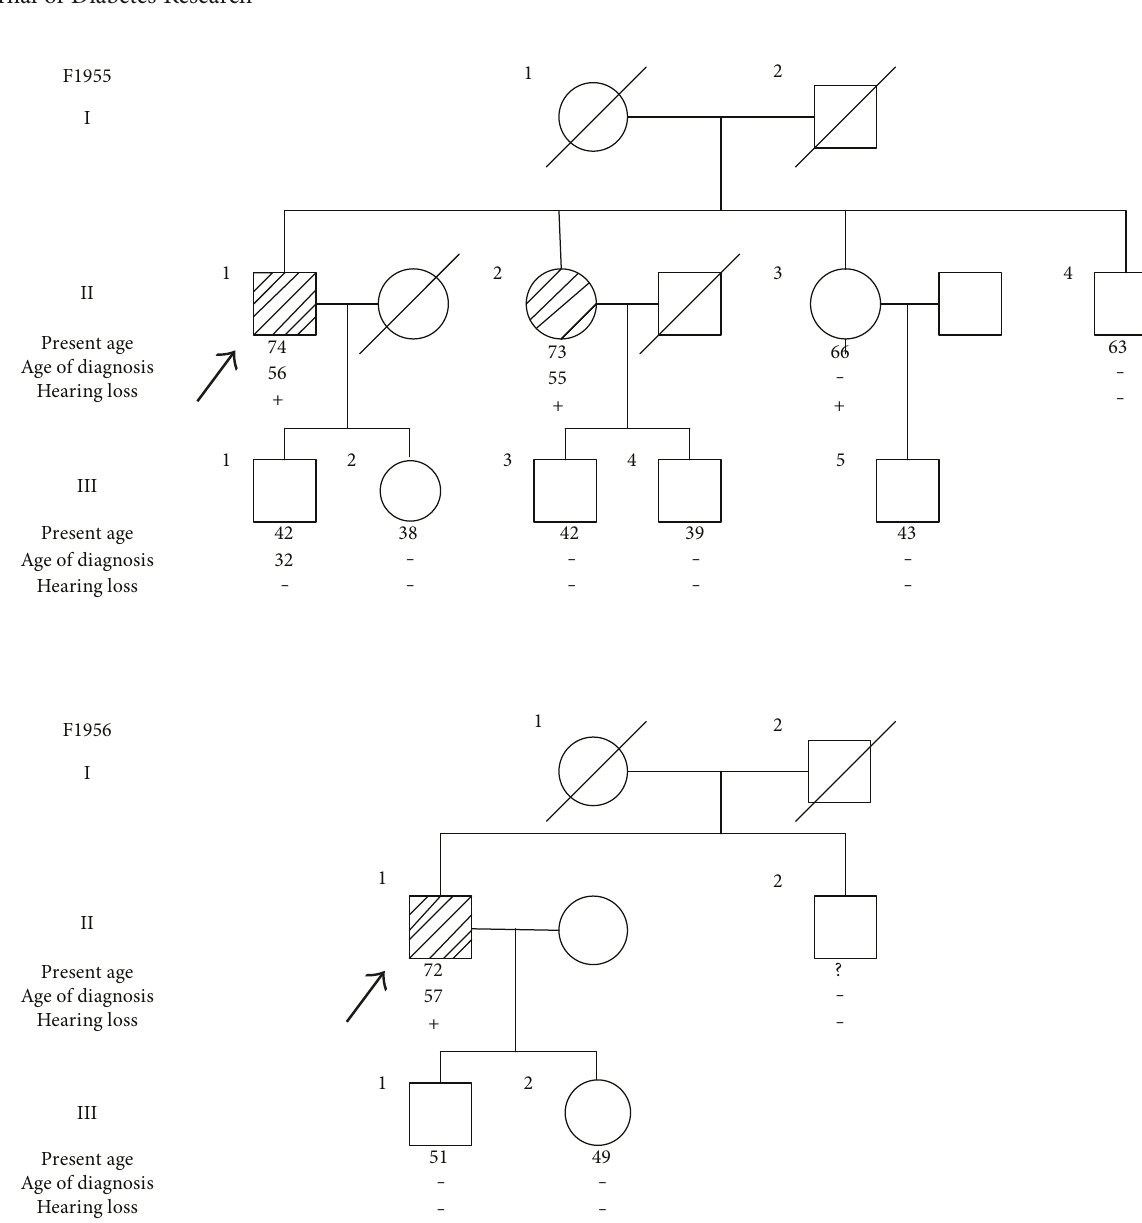
Figure 2: Pedigree of two families with mt3243A > G mutation (F1955 and F1956). ○ =female; □ =male; , ▨ = patients with mt3243A > G mutation;